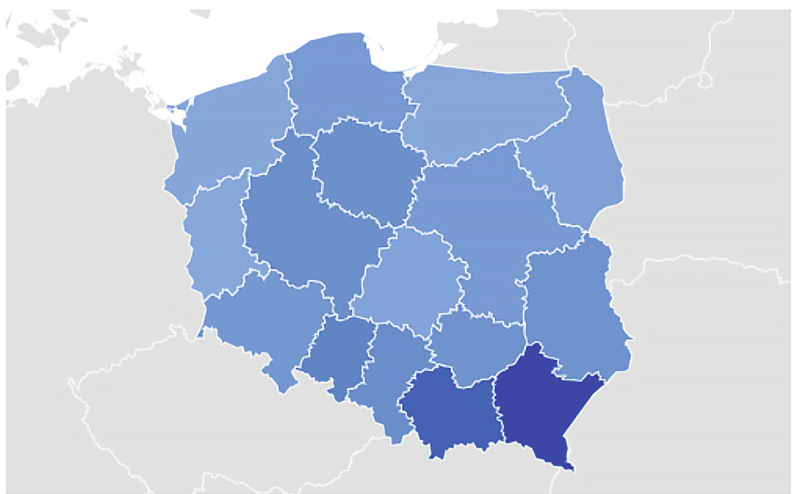
Figure 11. Frequency of searches for the keyword “confession” in the last five years by region; source: Google Trends, https://www.google.com/trends (accessed on 23 August 2021).